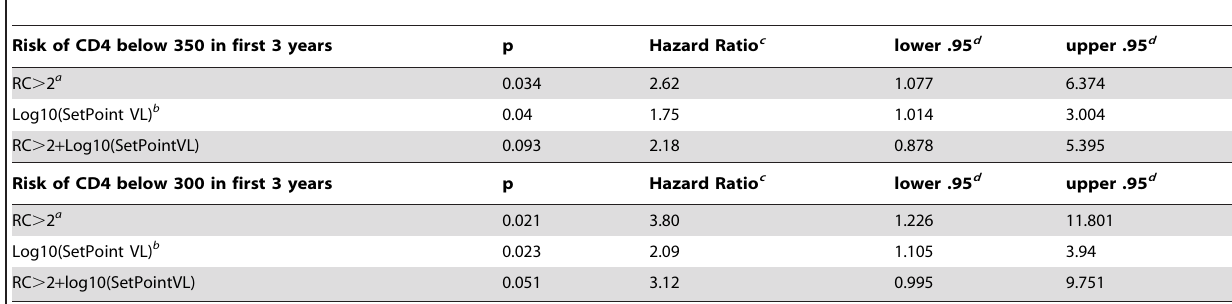
Table 2. Cox proportional hazard models demonstrate the independent effects of RC and VL on CD4 decline.